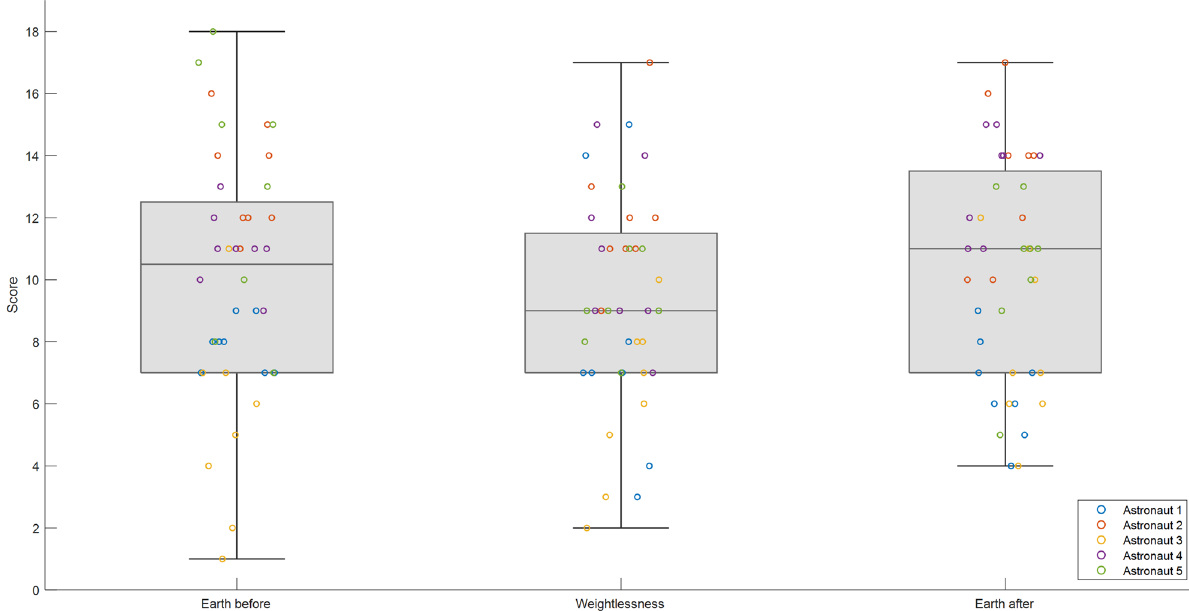
Figure 2. Scores on the docking task. Scores over a value of 20 (because 20 trials) for each of the 4 series per session (two per condition, Earth before , Weightlessness and Earth after ). Boxes represent the inter-quartile range between the 25 and 75 percent quartiles, the horizontal line inside the box indicates the median, the vertical lines mark the minimum and the maximum scores). Individual scores in blue, orange, yellow, violet and green cercles for Astronauts 1, 2, 3, 4 and 5